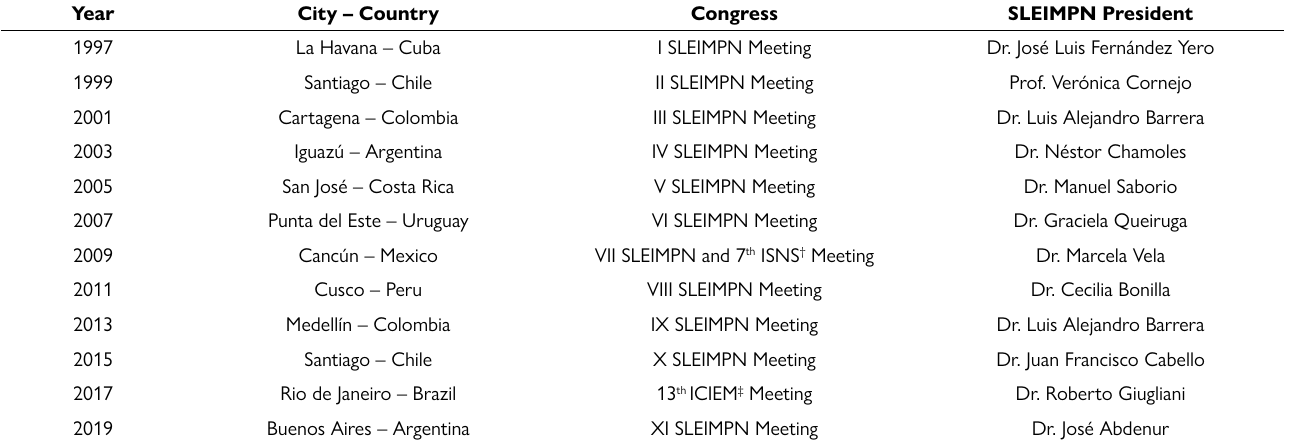
Table 1. Summary of Inborn Errors of Metabolism and Newborn Screening Latin American Meetings hold from 1997 to 2019 organized by the